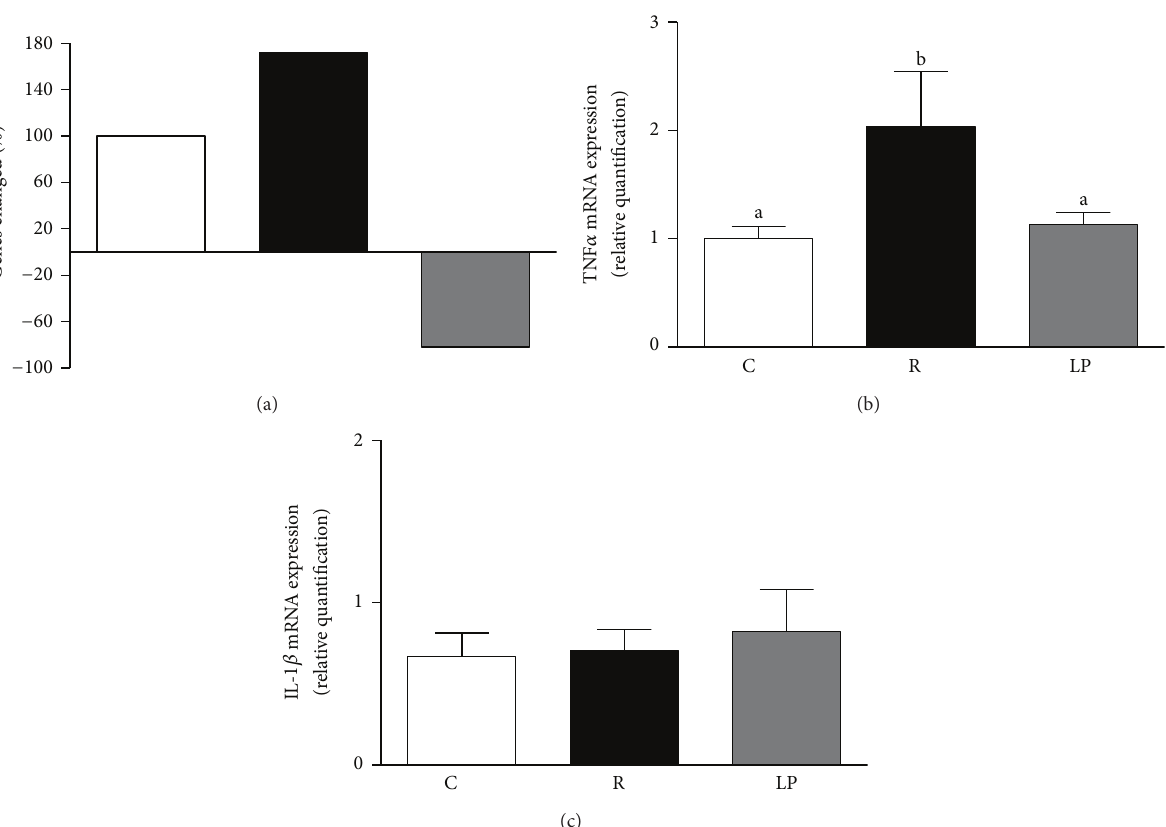
Figure 3: Fold change genes modulated by the experimental treatments evaluated in hypothalamus by PCR array (a). TNF 𝛼 (b) and IL-1 𝛽 (c) mRNA expression in hypothalamus of control (C), recovered (R), and low protein (LP) rats. Data are presented as means ± SEM. Mean values with unlike superscript letters were significantly different ( 𝑃 < 0.05 , LSD test).